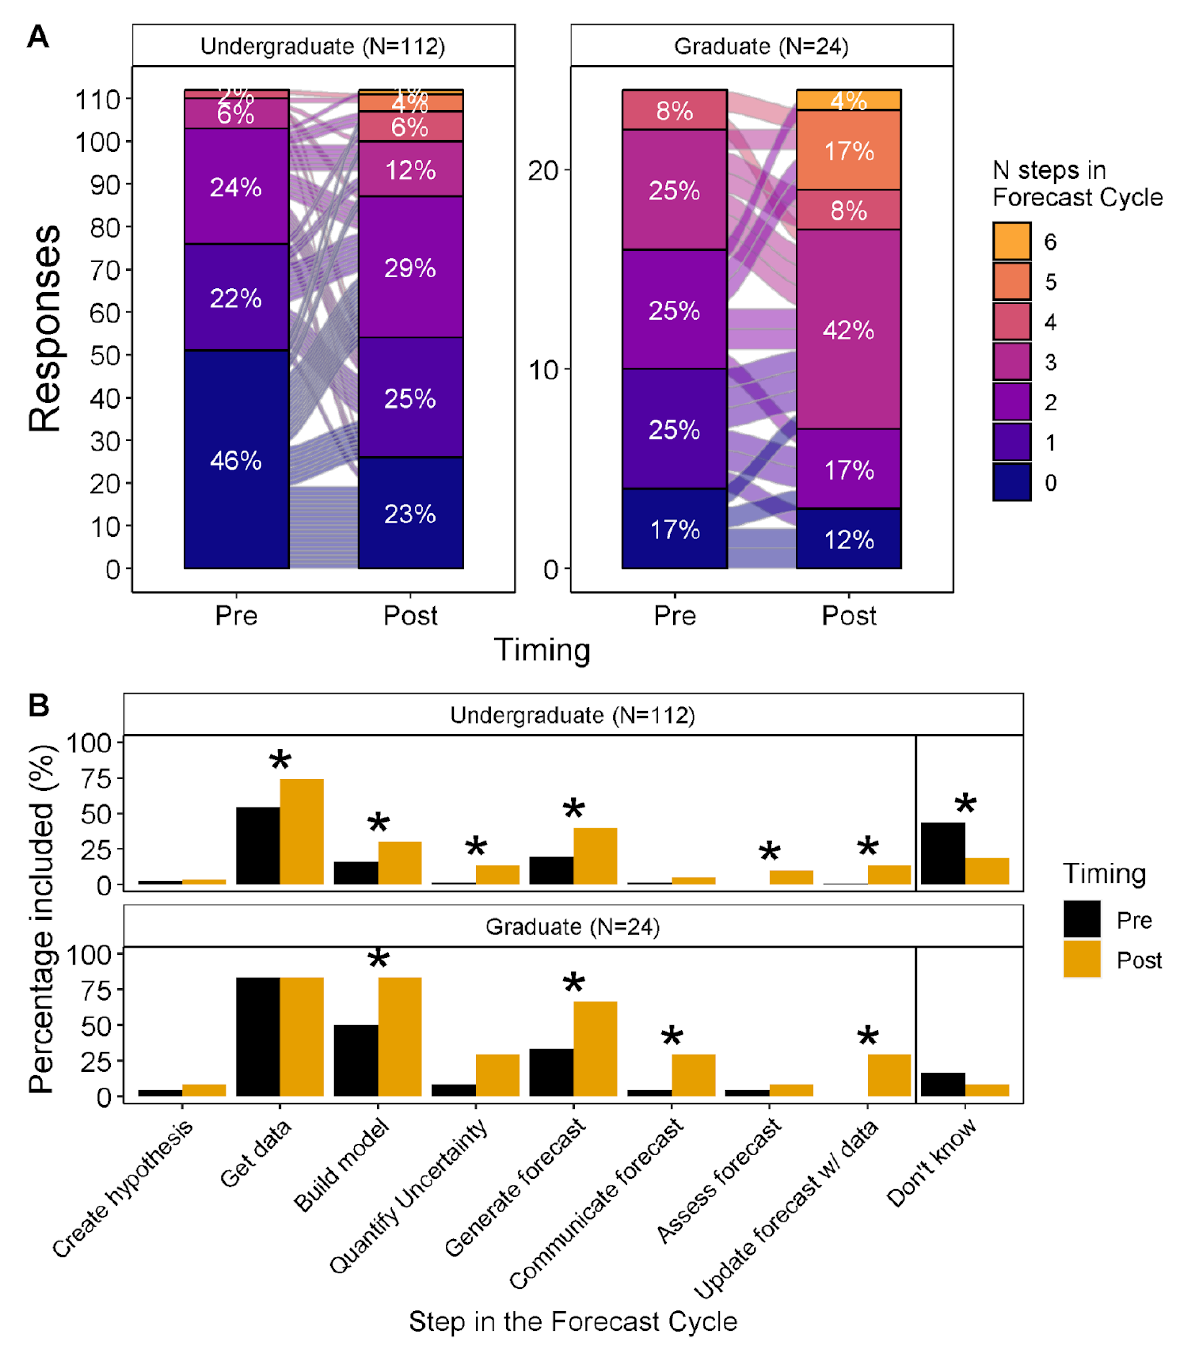
Figure 4. ( A ) Percentage of undergraduate (n = 112) and graduate students (n = 24) who included zero to six steps of the INTEF cycle in their answer to the question about how they would develop lake algae forecasts in the pre- and post-module assessment. The lines between the vertical bars represent changes by individual students between the number of forecast steps included in pre- and post-module responses. ( B ) Percentage of undergraduate (n = 112) and graduate students (n = 24) who included each of the steps of the INTEF cycle (corresponding to Figure 1) in their pre- and post- module assessment responses to the question about how they would forecast lake algae. Students were also given the option to state “I don’t know.” Stars (*) indicate statistically significant ( p < 0.05) differences between the pre- and post-module assessments (statistical results presented in Table A8).